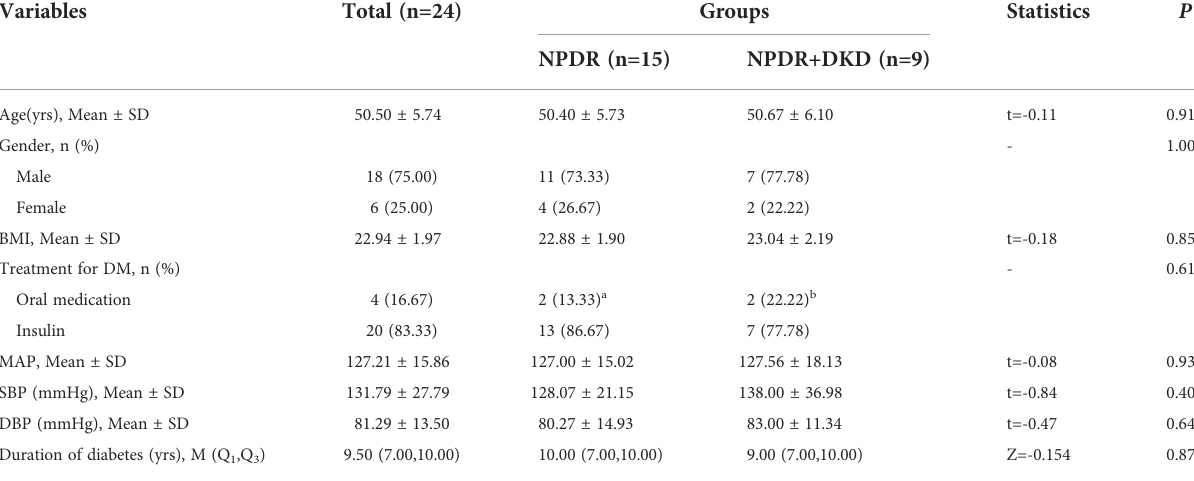
TABLE 1 Characteristics of NPDR and NPDR+DKD patients for plasma collection and LC-MS/MS